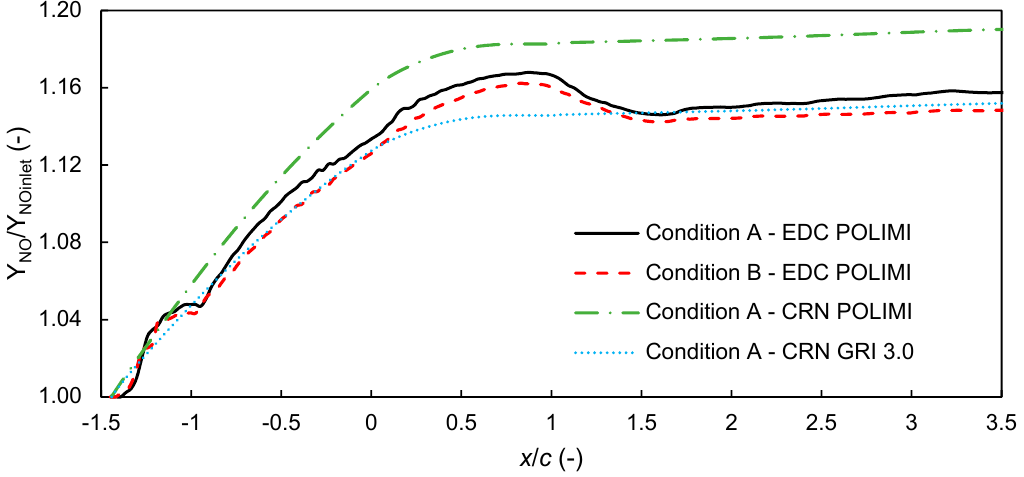
Figure 9. Mass-averaged NO mass fractions as functions of the axial location.